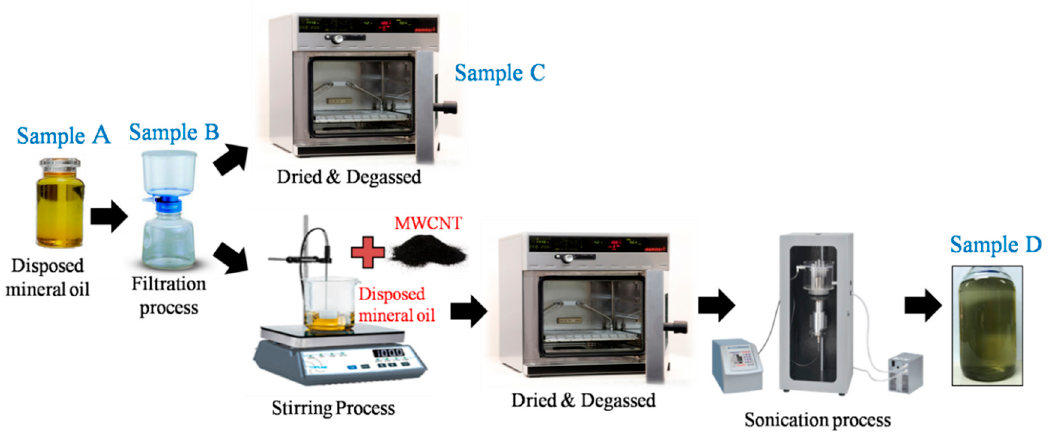
Figure 4. Preparation process of MWCNT nanofluid.